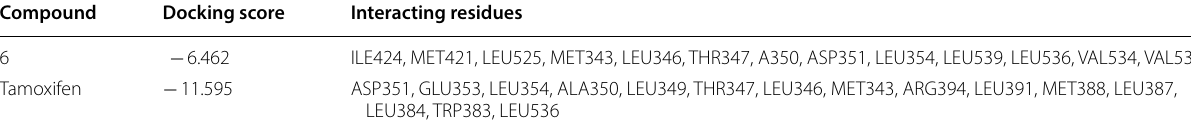
Table 5 Docking score and binding energy of compound 6 with standard drug (tamoxifen) Compound